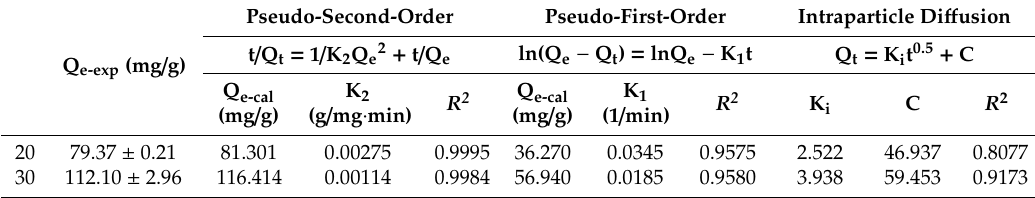
Table 1. Adsorption kinetic parameters of the adsorption of methyl orange (MO) onto the polyaniline (PANI) / poly(styrene–methyl methacrylate–acrylic acid) (PSMA) adsorbent at pH 4.0 and 25 ◦ C. The initial concentrations were 20 and 30 mg / L.